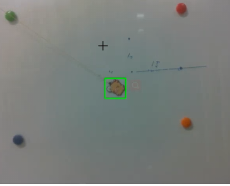
Figure 10. The result of error.